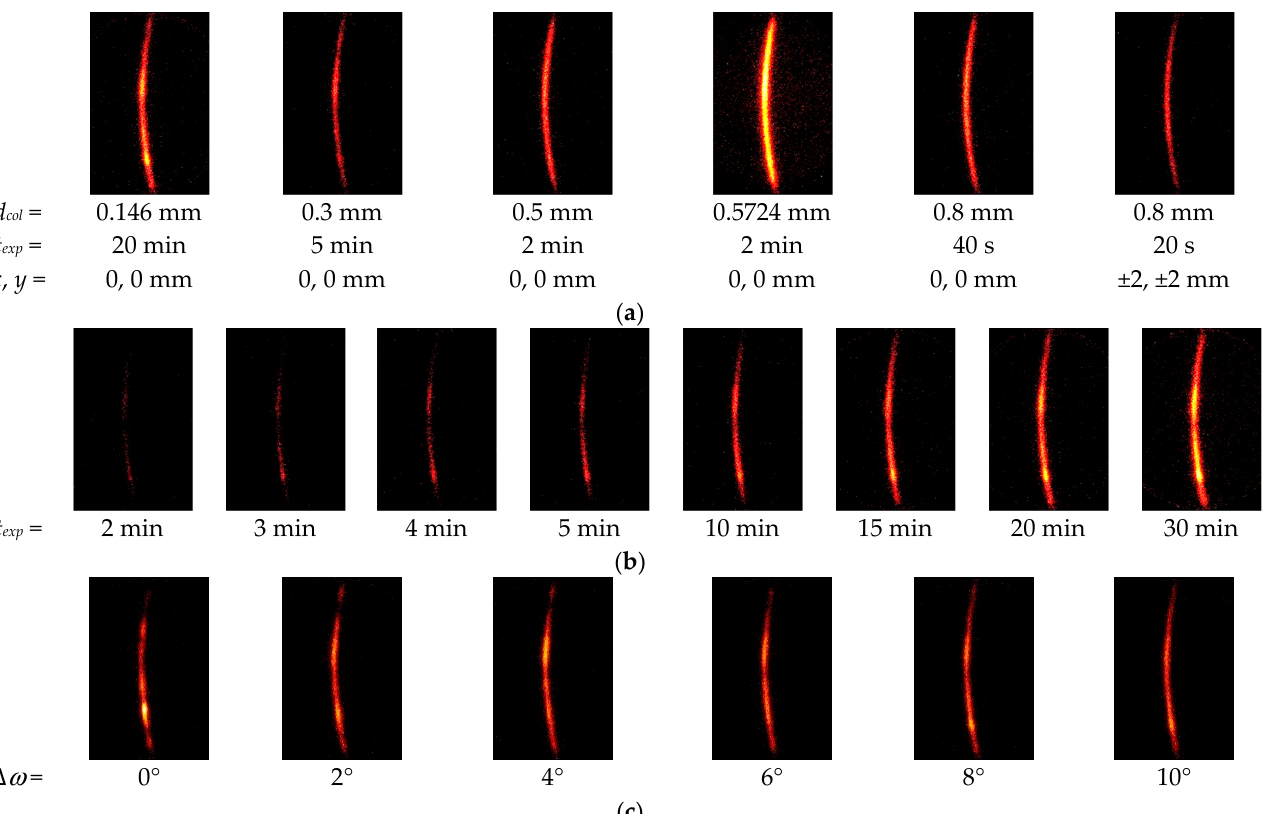
Figure 10. Typical X-ray diffraction patterns detected by 2D-PSPC at ψ = 0° and φ = 0° from stainless steel treated by cavitation peening (Specimen A). ( a ) effect of the collimator diameter d col at ∆ ω = 8°; ( b ) effect of exposure time t exp at d col = 0.146 mm and ∆ ω = 8°; ( c ) effect of the ω -oscillation angle ∆ ω at d col = 0.146 mm and t exp = 20 min.